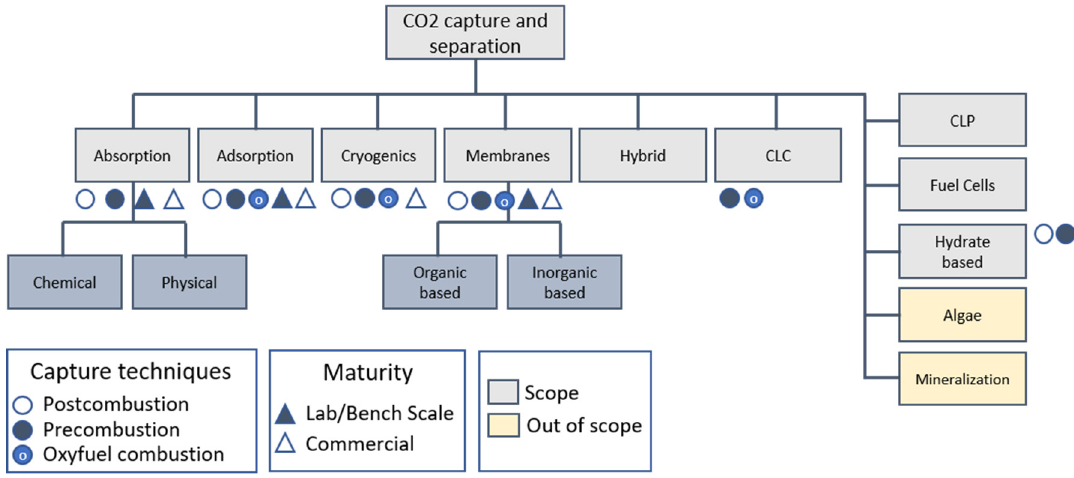
Figure 14. Relationship between carbon capture and separation techniques. Data source: [112,114].